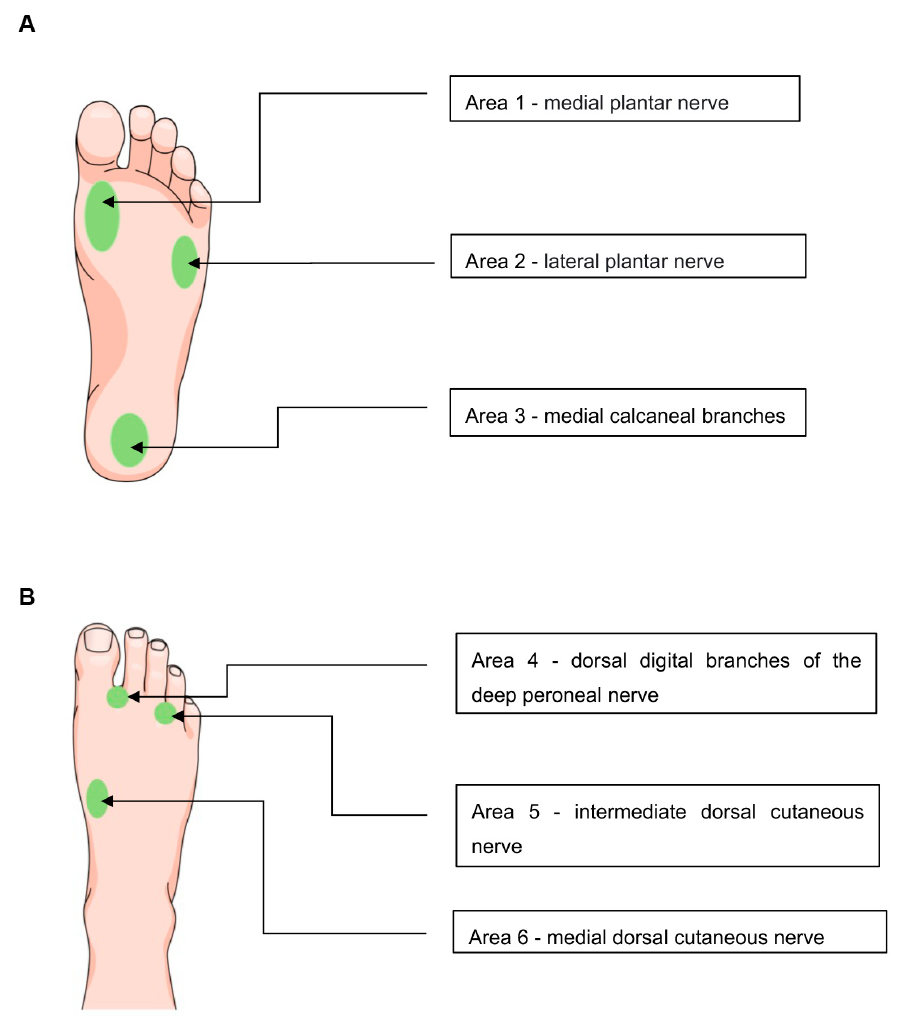
Figure 2. Areas of sensory testing. ( A ) In areas 1, 2, and 3, tactile thresholds and static and dynamic two-point discrimination are tested, sampling all major branches of the tibial nerve distal to the entrapment site in the tarsal tunnel. ( B ) In areas 4, 5, and 6, tactile thresholds and static and dynamic two-point discrimination are tested for the major branches of the deep and superficial peroneal nerve.